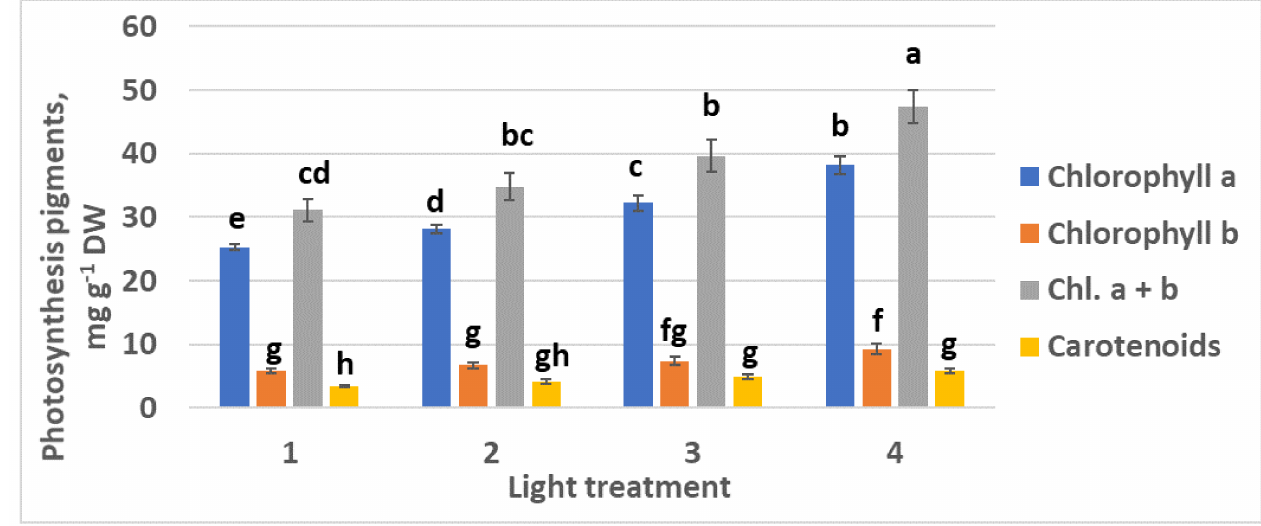
Figure 6. Chlorophylls and carotenoids content in the leaves of raspberry plants grown under various red (R 660 )–far-red (FR) light ratio. Means ± standard error (SE); means followed by the same letter were not different at p ≤ 0.05. Treatment 1—0% R 660 + 100% FR; Treatment 2—30% R 660 + 70% FR; Treatment 3—70% R 660 + 30% FR; Treatment 4—100% R 660 + 0%